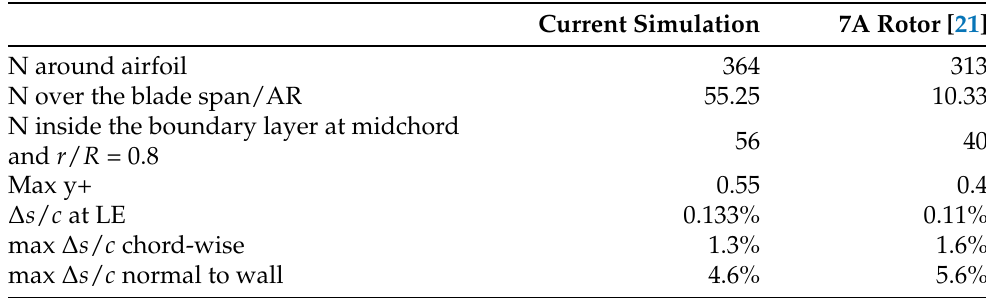
Figure 1. Configuration of the mesh: ( a ) blade block; ( b ) voxel rotating block; ( c ) voxel far-field block. Table 2. Comparison of the spatial resolution between current simulation and the 7A rotor mesh of